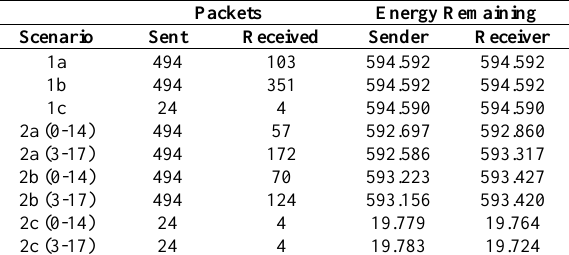
Table 21. Packets and Remaining Energy at -2 dB.